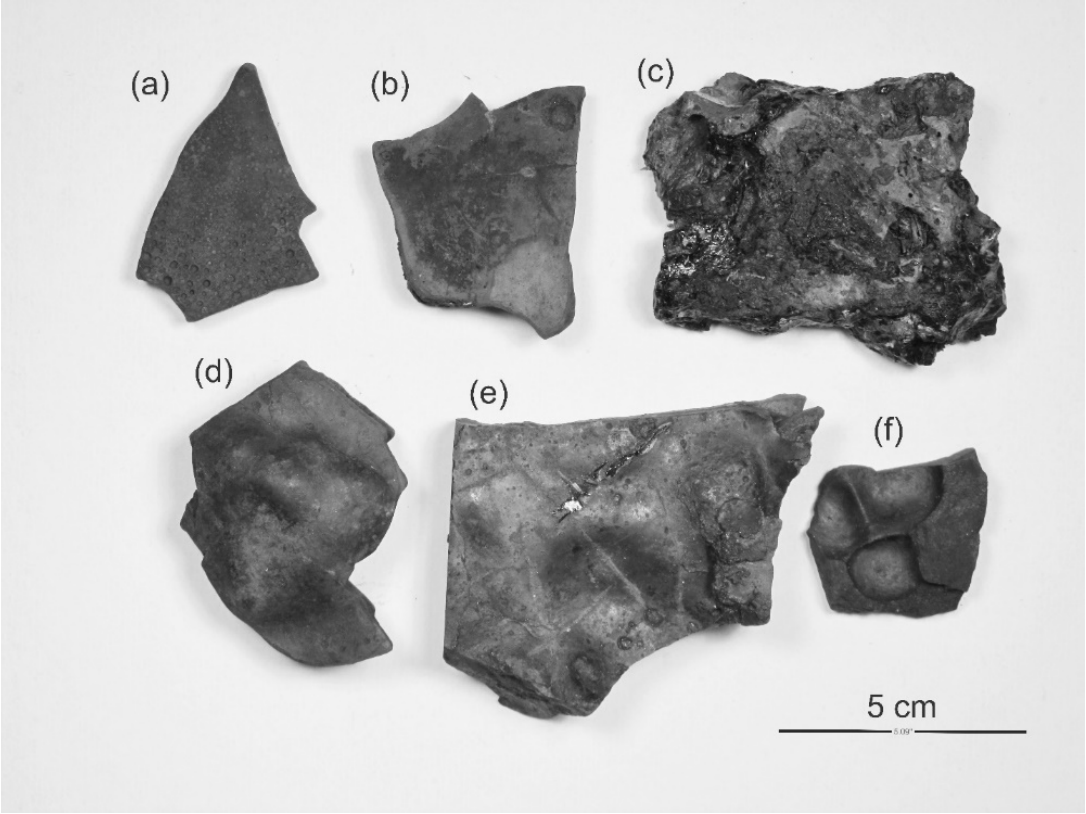
Figure 2. Photograph of Casaccia slags. ( a , b ) Plate-shaped magnetic slags; ( c ) slag with inclusions of host rock and ( d – f ) non-magnetic slags with bulges.